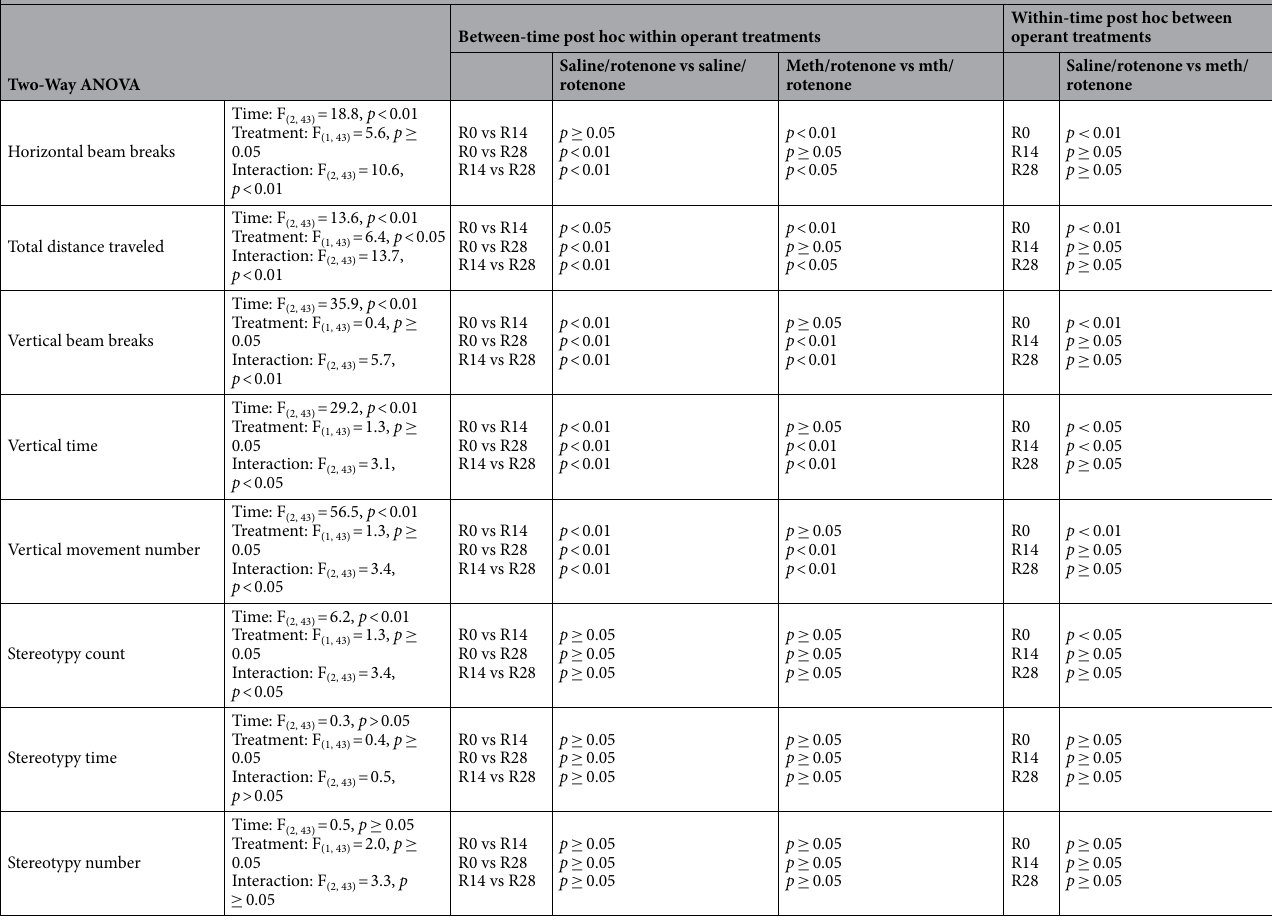
Table 5. Peak phase motor effects. Tested variables were rotenone administration time (Time) and operant- task treatment (Treatment). A Newman-Keuls was used for post-hoc comparisons.